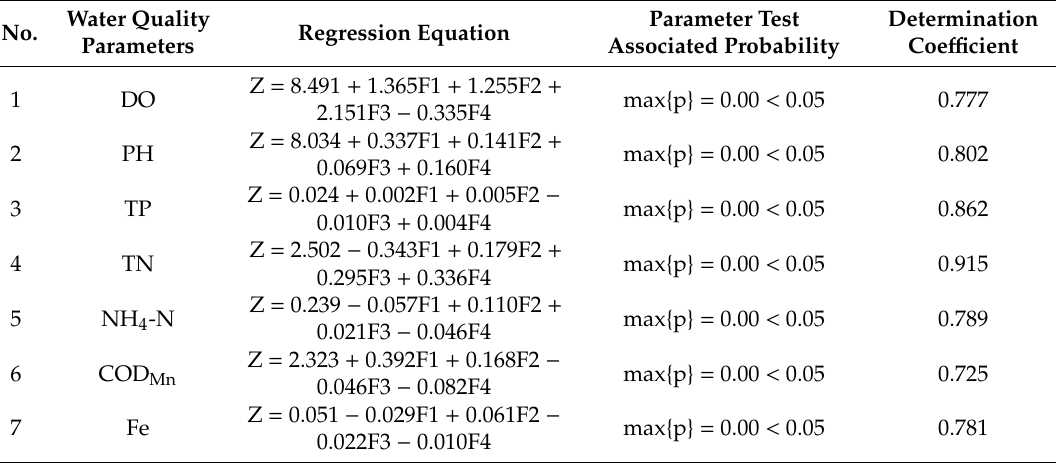
Table 4. Multiple linear regression of each